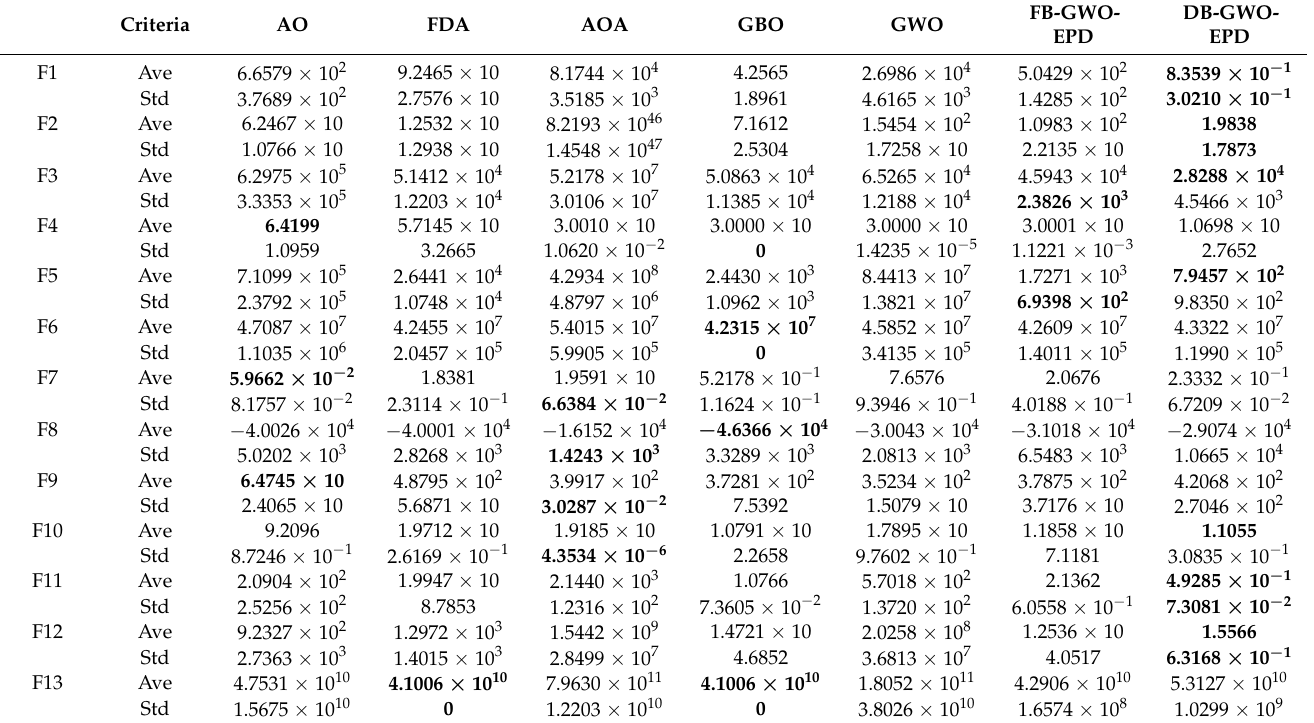
Table 5. Results of the DB-GWO-EPD and its rivals on the shifted benchmark functions, with n =